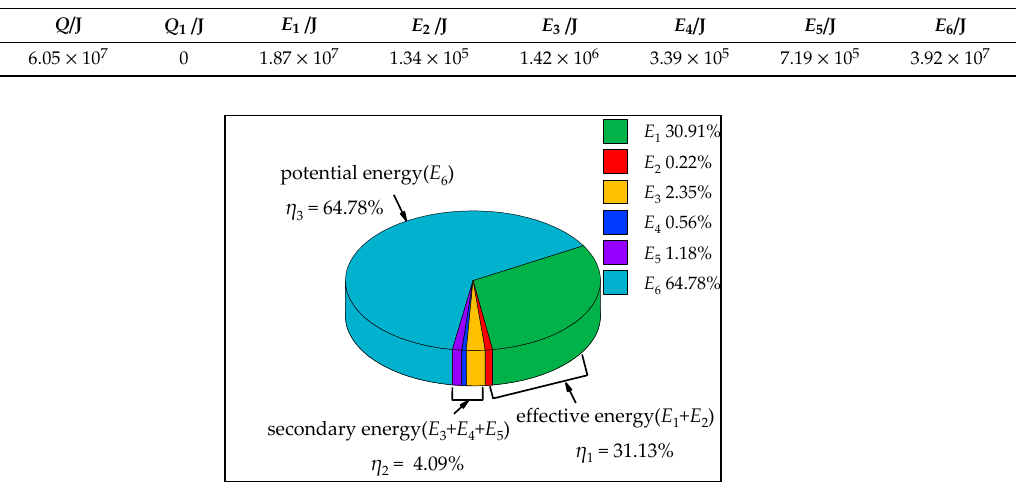
Figure 16. Sector diagram of energy distribution proportion.